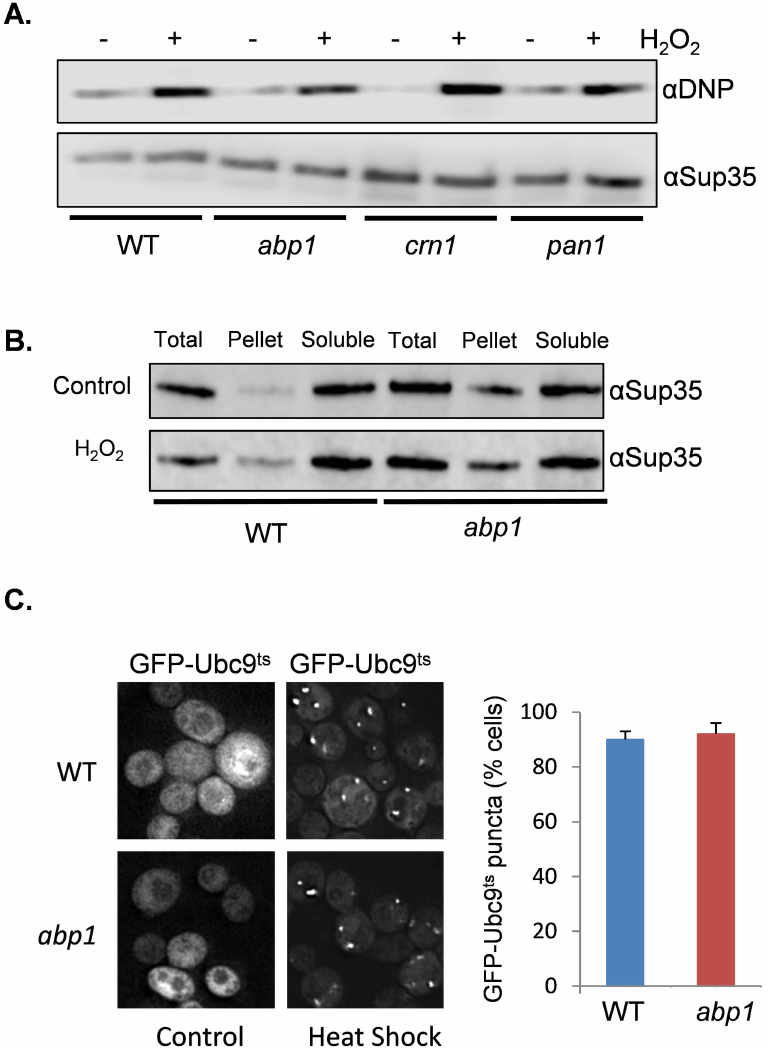
Fig 5. Analysis of protein oxidation and aggregation in an abp1 mutant. A. Mutants disruptingthe cortical actin cytoskeleton dot not affect Sup35protein oxidative damage.The wild-type, abp1 , crn1 and pan1 mutant strains were treated with 100 μ Mhydrogenperoxide for 20 hours and protein carbonylation used as a measureof protein oxidativedamage.Protein extracts were treated with the carbonyl-specific probe, DNPH, and analyzedby Western blot analysisusing an antibodyagainst DNPH. B. Subcellulardistributionof Sup35 in wild-typeand abp1 mutant cells grown in the presenceor absenceof 100 μ Mhydrogenperoxidefor 20 hours. Total denotestotal crude extract; Soluble,solublefraction; Pellet, SDS-resistant high molecularweight fraction. C. Representative fluorescent micrographs are shown for wild-typeand abp1 mutant cells expressing GFP–Ubc9 ts . Strains were grown in SRaf media before switchingto SGal media to induce GFP–Ubc9 ts expressionfor 3 hours. This was followedby a 37˚C heat shock for 30 minutes to trigger the misfoldingand aggregationof Ubc9. Quantificationof the frequencyof GFP–Ubc9 foci is expressedas the percentage of cells containingfluorescence foci out of approximately 300 cells counted. Error bars denote standard